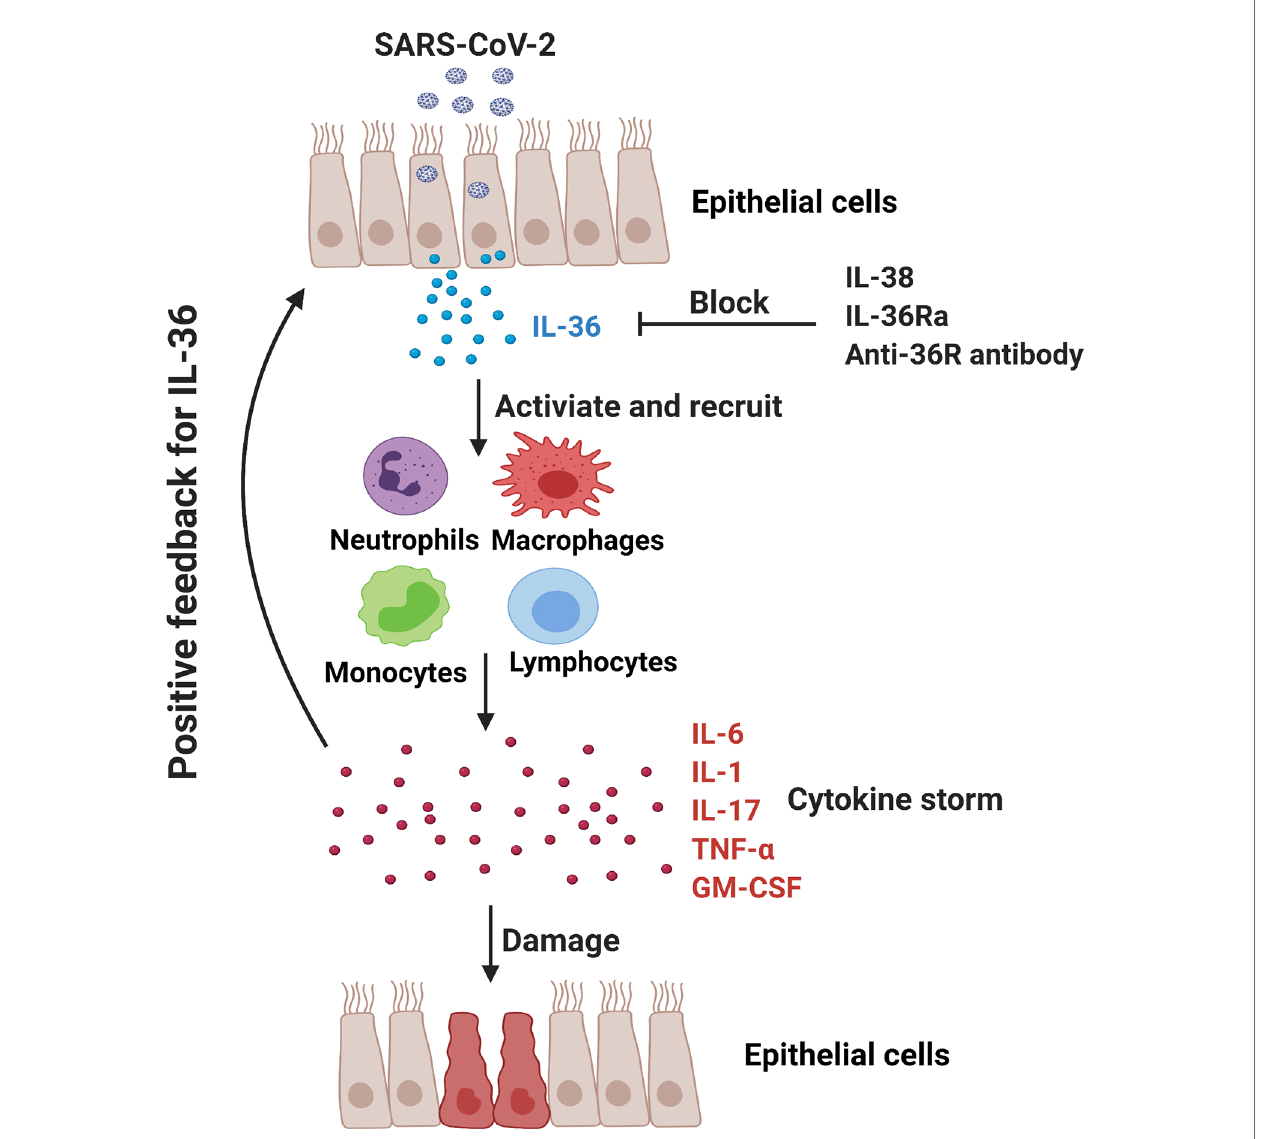
FIGURE 2 | In COVID-19 patients, SARS-CoV-2 may promote hyperin fl ammation in the lung and exacerbate tissue damage. IL-36-activated in fl ammatory immune cells (e.g., monocytes, macrophages, neutrophils and pathogenic T cells) produce IL-6, IL-1, IL-17, TNF- a and GM-CSF to further amplify IL-36 responses. IL-36Ra and IL-38, as the natural antagonistic mediators in IL-36 family might be a promising therapeutic target for COVID-19 via inhibiting IL-36 signaling pathway and alleviating pulmonary hyperin fl